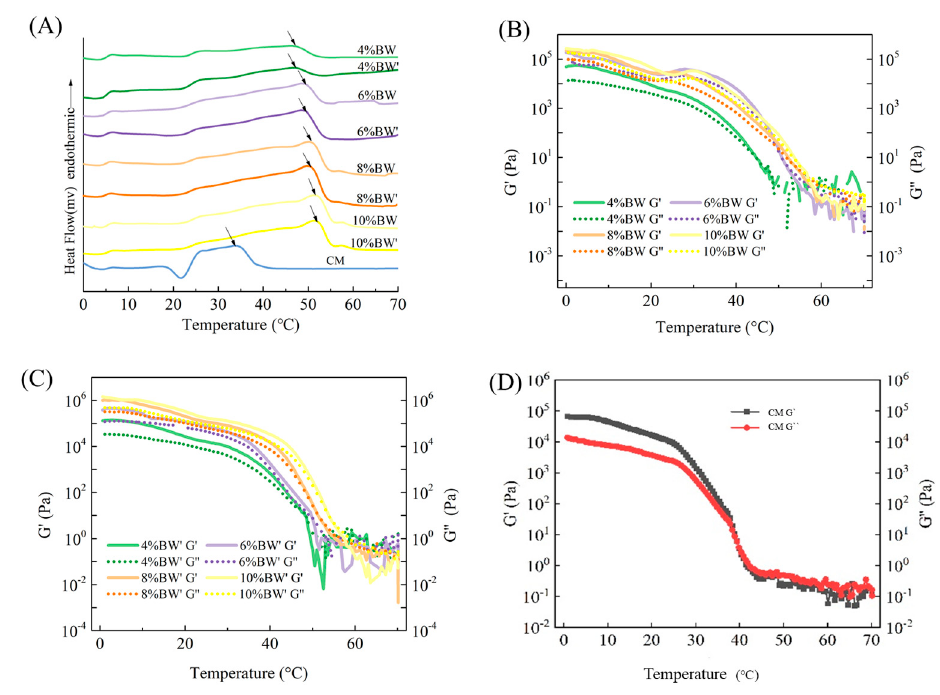
Figure 2. DSC melting curves ( A ), temperature ramps of BW oleogel-based margarine ( B , C ), and commercial margarine (CM) ( D ), respectively.